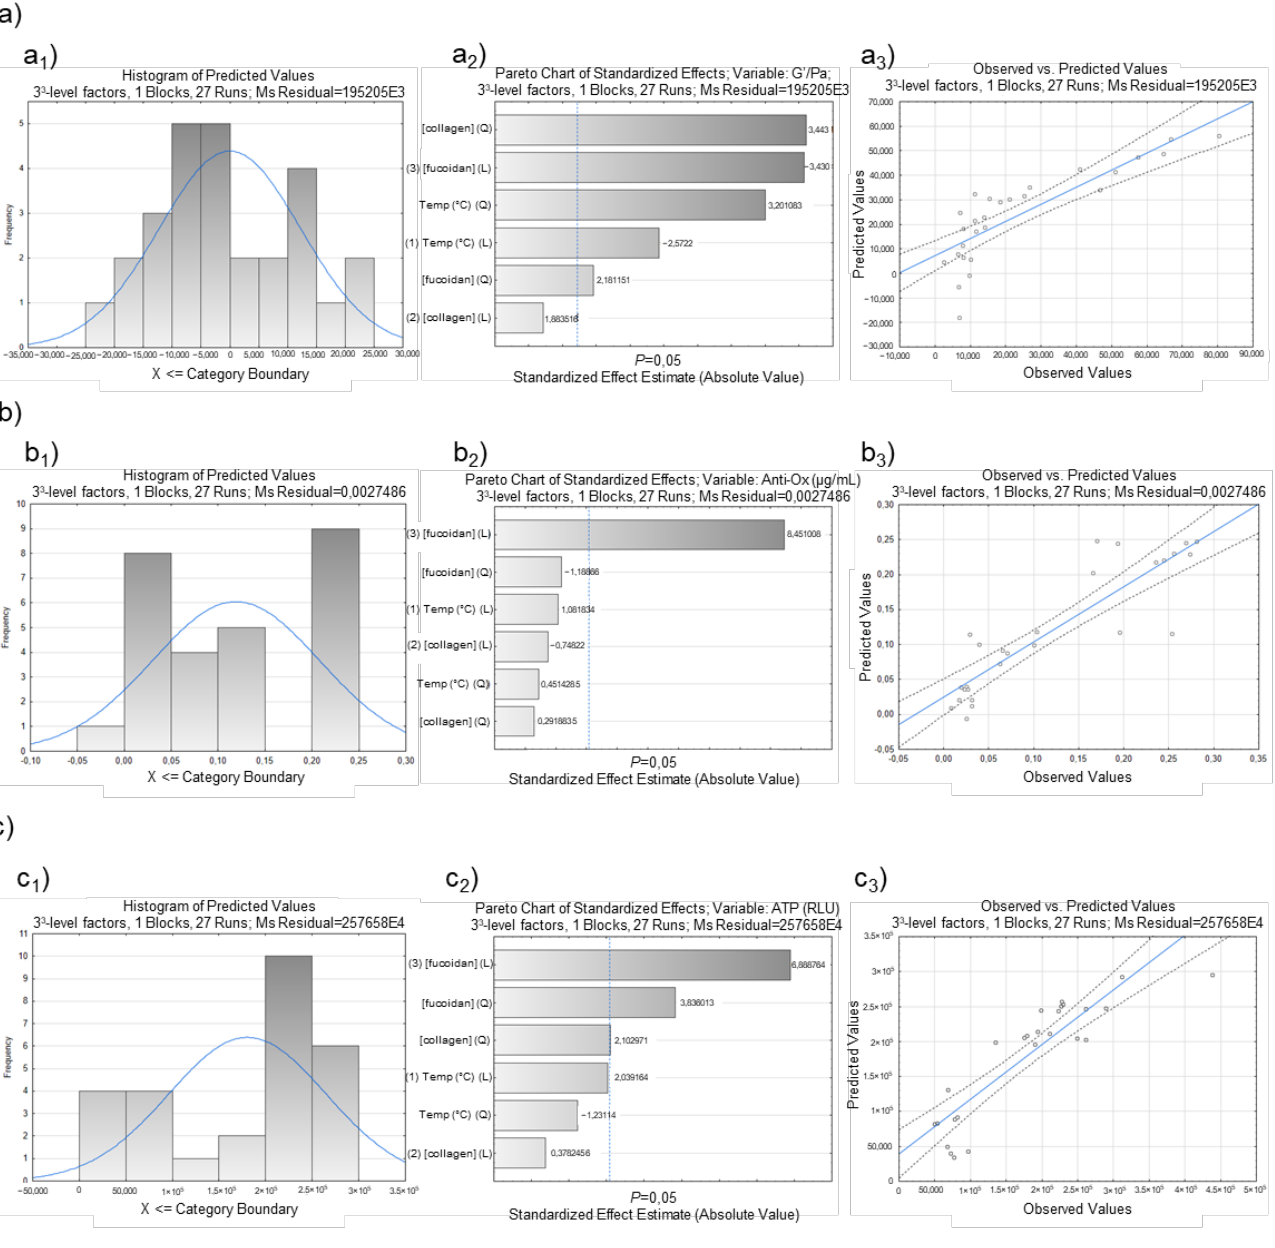
Figure 7. Factorial response of ( a ) rheological data (G ′ /Pa), ( b ) antioxidant activity (µg/mL), and ( c ) ATP (RLU) measurements on marine origin cryogels. The images ( a 1 , b 1 , and c 1 ) demonstrate the histogram of distribution; ( a 2 , b 2 , and c 2 ) represent the Pareto charts of standardized effects of the factorial design, while the images of ( a 3 , b 3 , and c 3 ) show the Box–Behnken design plot for predicted versus actual values for each response variable.